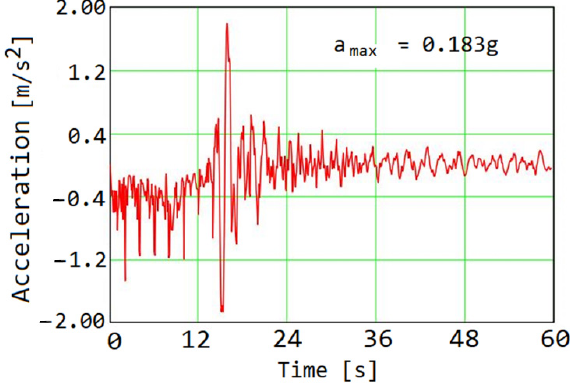
Figure 18. Acceleration versus time for the 4 March 1977 earthquake.